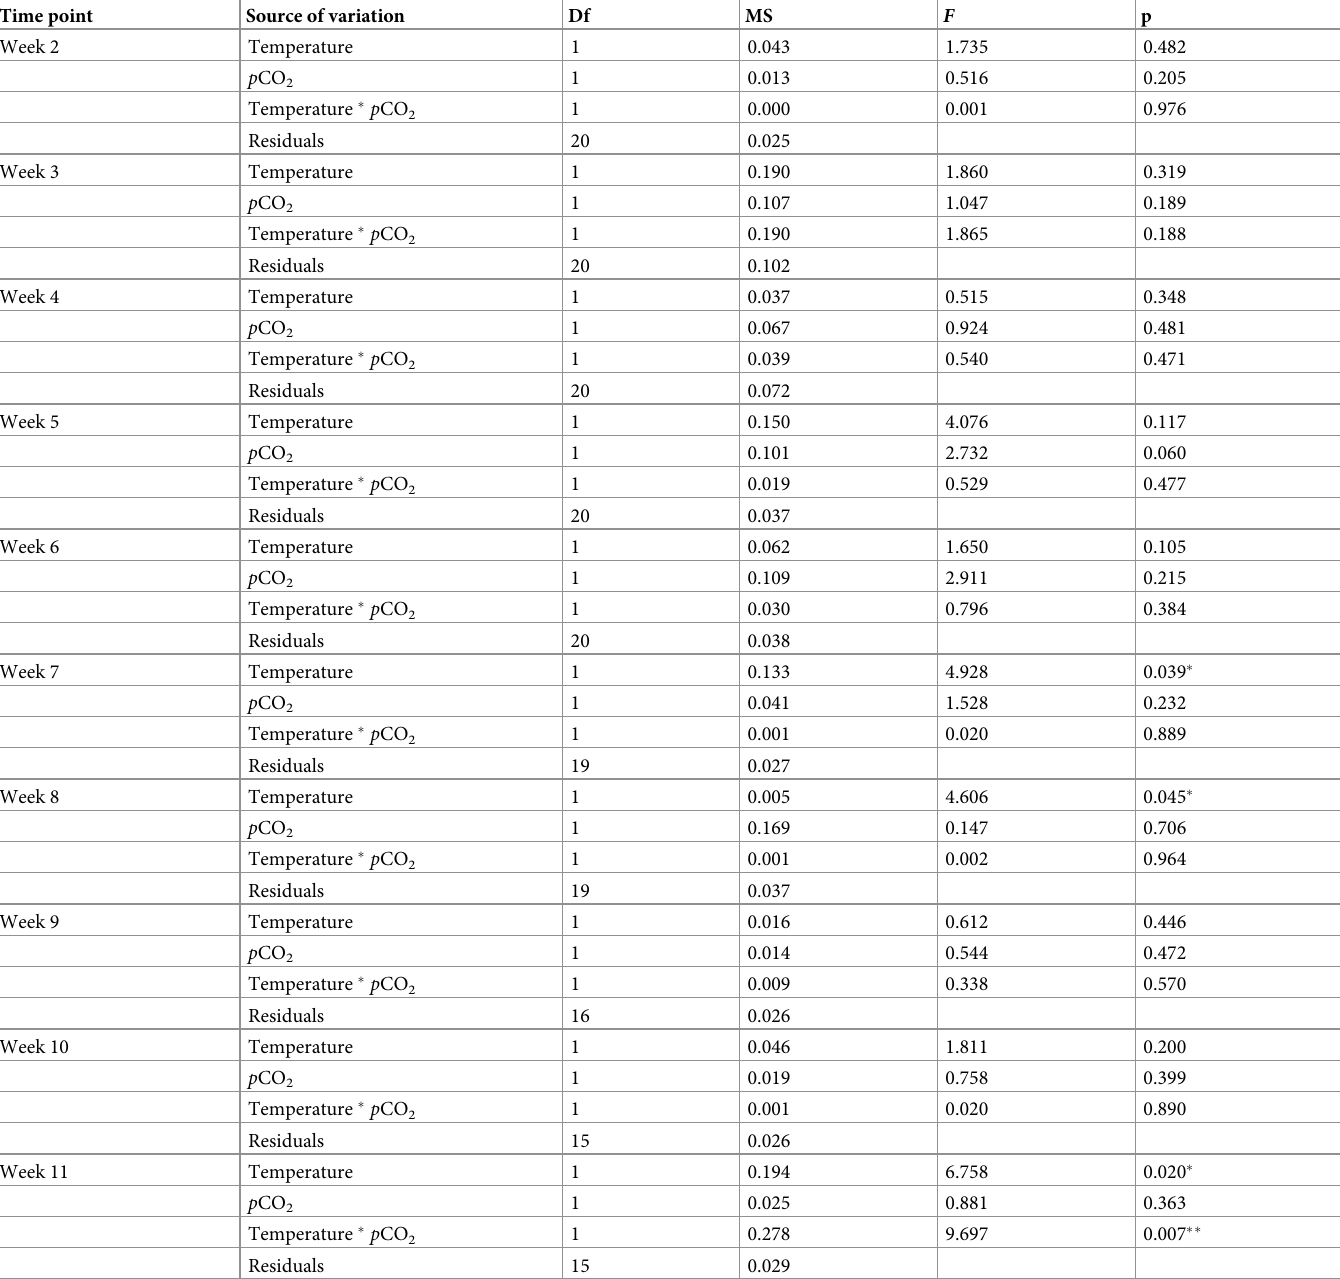
Table 2. Results of two-way analyses of variance (ANOVA) to test the effects of increased temperature and p CO 2 (decreased pH) on the average growth of Sporoli- thon